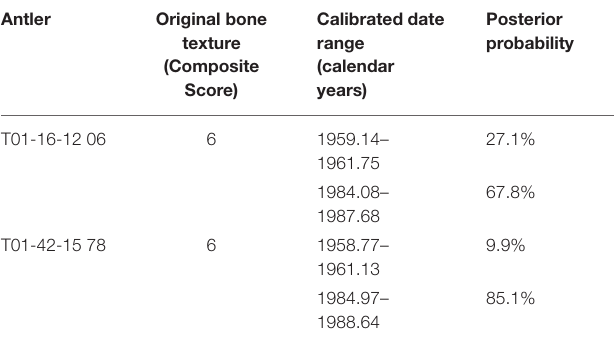
TABLE 1 | Antlers with conflicts between weathering features and most-supported ranges of post-bomb (BombNH13) calibrated AMS dates. Antler